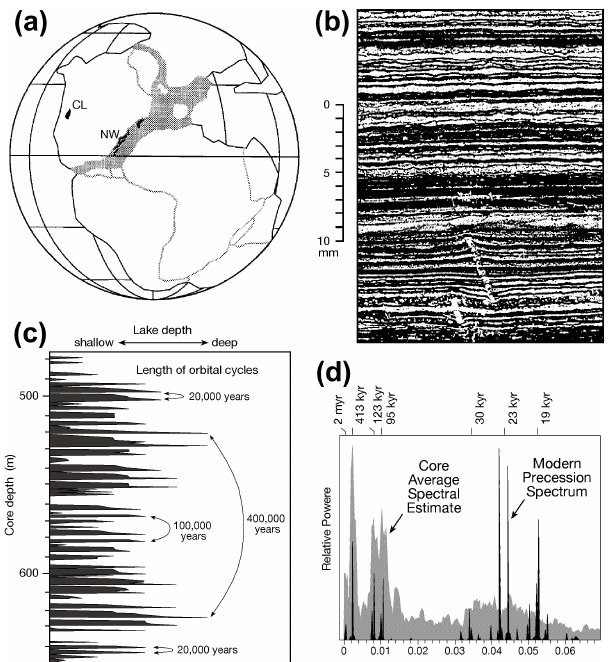
Figure 20. Late Triassic monsoon records in North America. (a) Pa- leogeographic map showing the locations of the Colorado Plateau, with the Chinle Formation (CL) indicative of the margin of the trop- ical monsoon region, and a chain of rifted basins in the east with the Newark Supergroup (NW). (b) Photograph of microlaminated mudstone showing organic-rich/carbonate-rich couplets as annual varves. (c) Lake-level fluctuations in a section of the Newark lake sediments, showing 20, 100, and 400ka cycles. (d) Average spectral estimates of sediment cycles in the Newark Basin with the modern precession spectrum (Wang and Li, 2009; modified from Olsen and Kent, 1996, and Ruddiman,